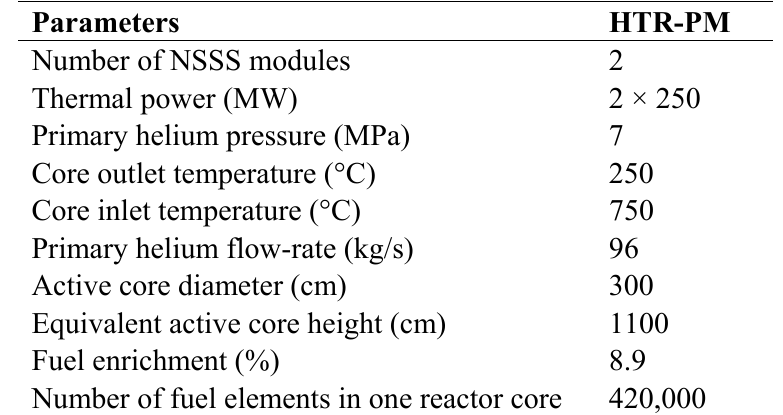
Table 1. Main design data of the HTR-PM reactor